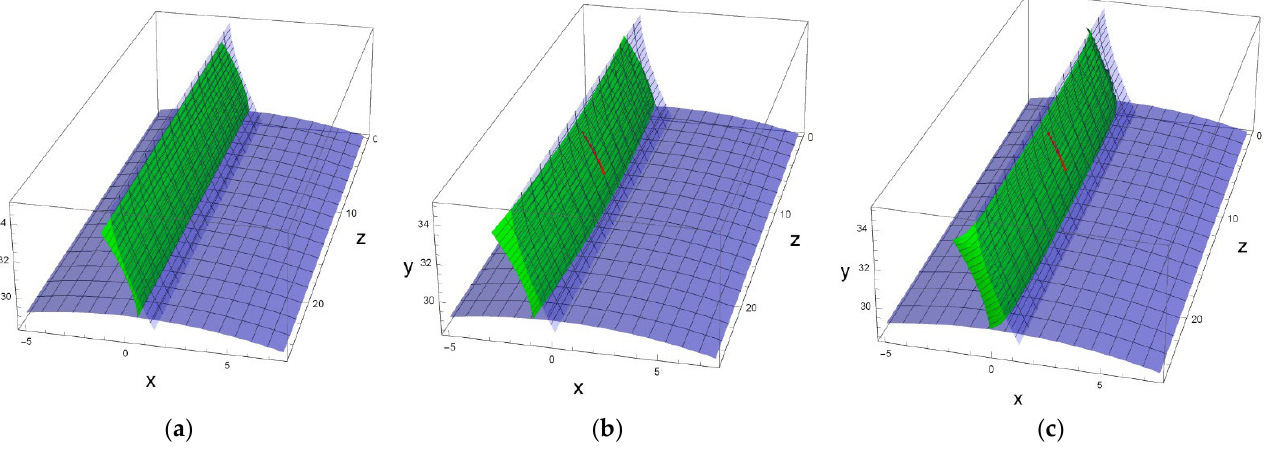
Figure 13. Assembly models of spur gears with ( a ) unmodified surface, ( b ) circular crowning, and ( c ) logarithmic crowning.